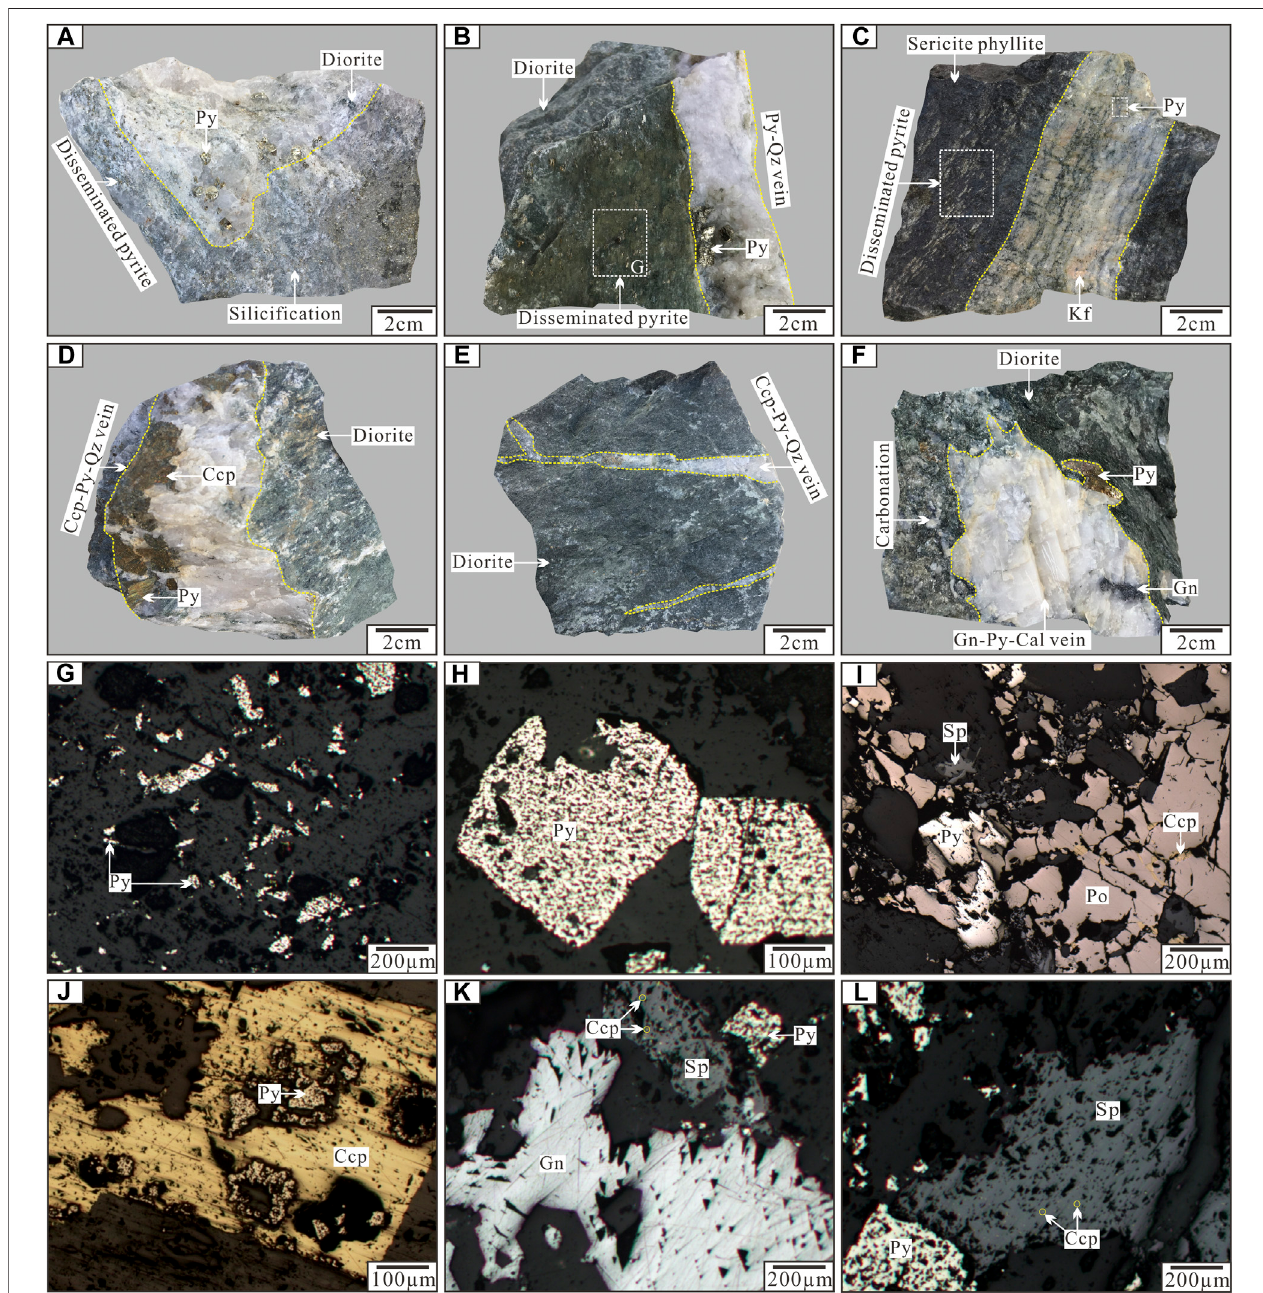
FIGURE 3 | Photographs of ore and mineral assemblages from the Jinba gold deposit. (A) Disseminated pyrite occurring in the diorite with silici fi cation; (B) Quartz – pyrite – gold vein indiorite; (C) Quartz vein – type mineralization in sericite phyllite; (D, E) Quartz – chalcopyrite – pyritevein indiorite; (F) Calcite – galena – pyrite vein in the diorite with carbonation; (G) Disseminated pyrite; (H) Euhedral – subhedral pyrite; (I) Interstitial chalcopyrite in pyrrhotite; (J) Pyrite replaced by chalcopyrite; (K) Galenaandsphaleriteaggregation; (L) Chalcopyriteemulsioninsphalerite.Abbreviations:Qz(quartz);Py(pyrite);Po(pyrrhotite);Ccp(chalcopyrite);Sp(sphalerite); Gn